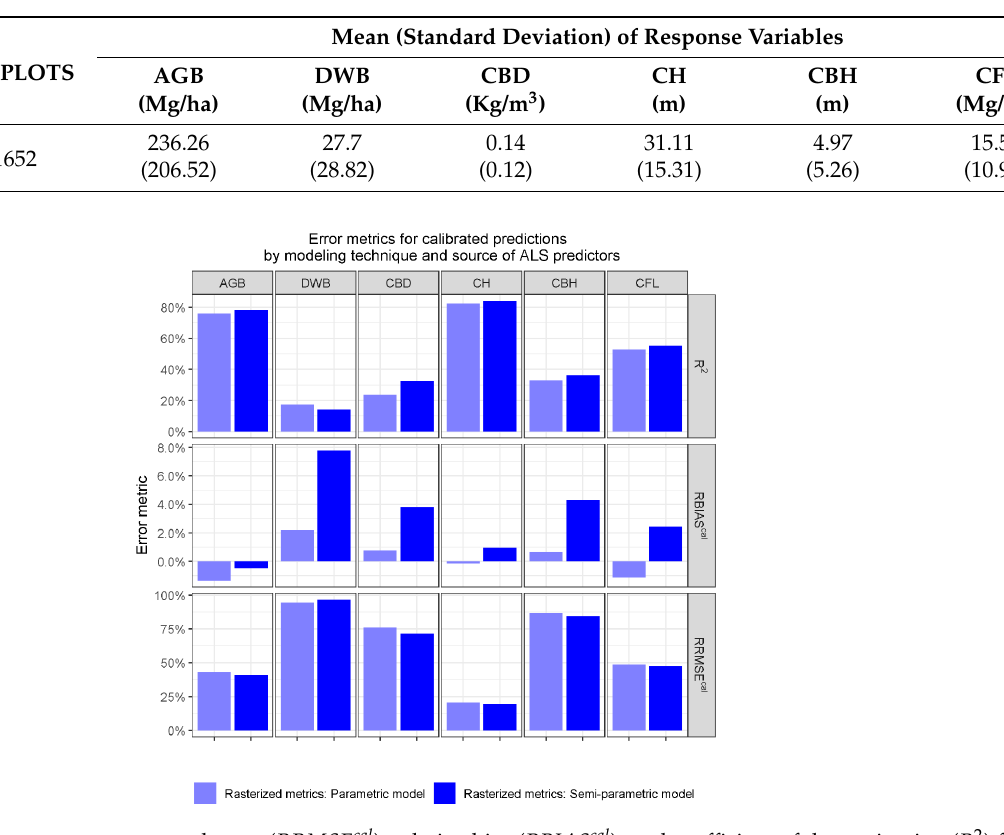
Table A2. Means and standard deviations of the variables of interest in the extended dataset.